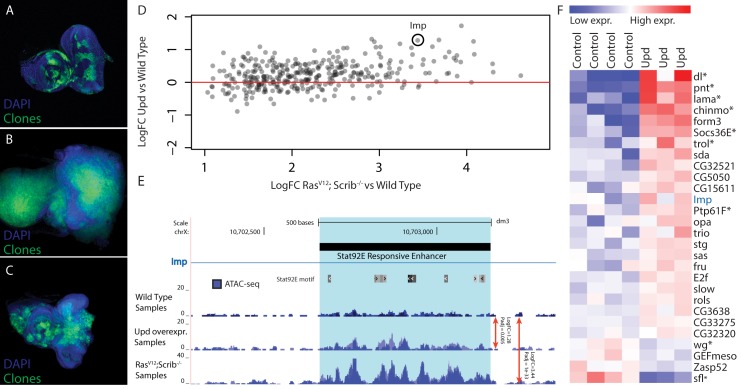
Validation of Stat92E as a key regulator during RasV12; scrib
-/- oncogenesis.(A-C) Confocal images of eye-antennal imaginal discs, clones are indicated in green and DAPI in blue. (A) Wild type disc from a 5 day old larva with MARCM clones expressing GFP (B) An eye-antennal tumor taken from an 8 day old larva with the RasV12; scrib
-/- clones. (C) An eye-antennal disc from an 8 day old larva with the RasV12; Stat92E85c9, scrib
-/- clones, showing partial rescue of the tumor phenotype. (D) Opening of predicted Stat92E enhancers from RasV12
; scrib
-/- tumors vs wild type (x-axis), compared to the opening of these enhancers when ectopically activating the JAK/STAT signaling pathway vs wild type (y-axis). (E) Predicted Stat92E enhancer region inside an intron of Imp, the enhancer is significantly more active in the Upd eye discs compared to wild type (logFC 1.28 padj 0.005) and even more so in the RasV12; scrib
-/- tumors compared to wild type (logFC 3.44 padj 1e-33). (F) Heatmap showing the expression level of 28 genes [42] that have at least one activated enhancer predicted to be Stat92E responsive (Fig. 6A).